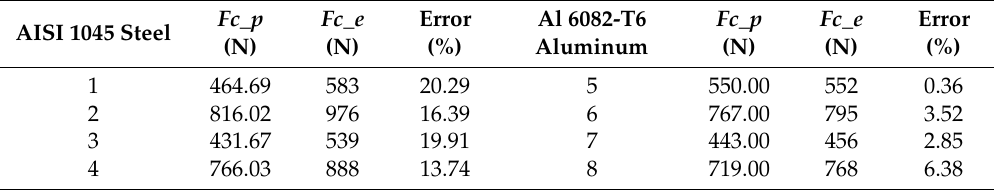
Table A1. Validation for the documented temperature using the force comparison